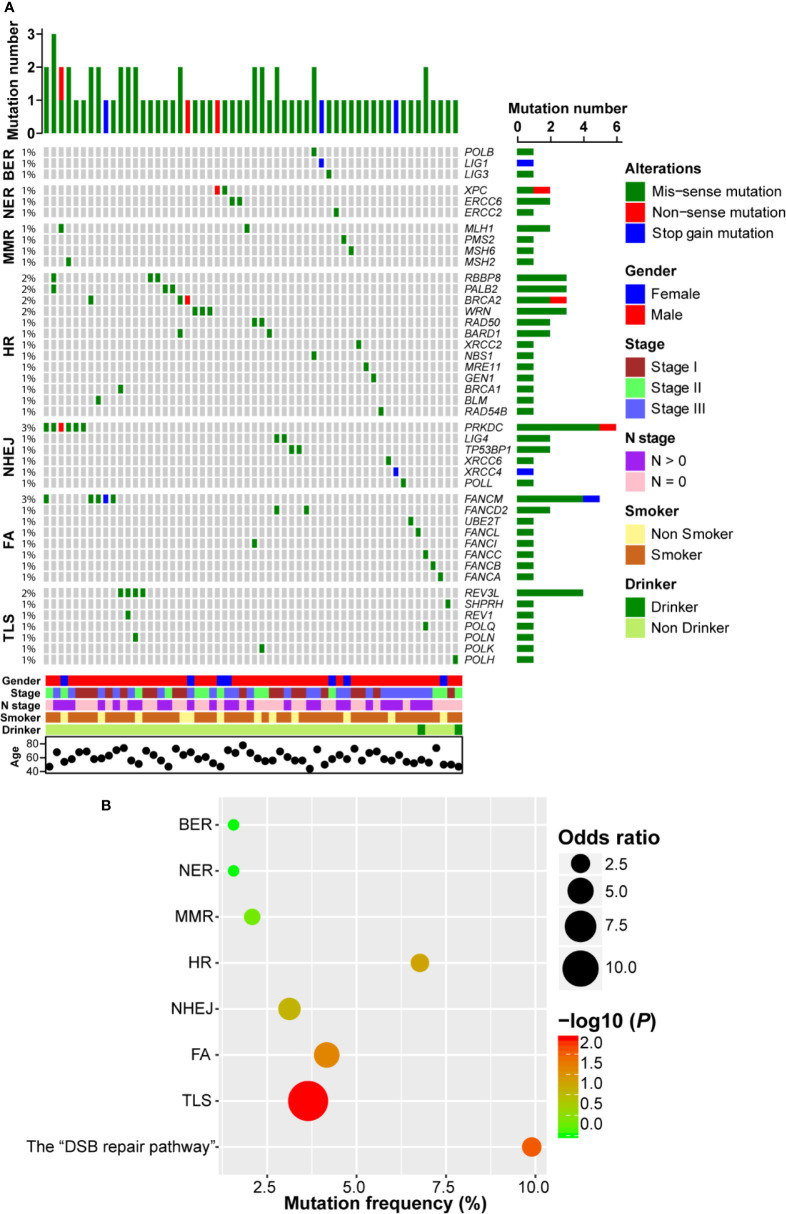
DNA damage repair (DDR) pathway genes were mutated in esophageal squamous cell cancer (ESCC). (A) A complex heatmap that shows the non-silent gene mutation profile in DDR pathways (genes and samples with no gene mutations are removed). The top panel presents the number of gene mutations in each of ESCC samples, and the right panel shows the number of gene mutations in each gene. (B) A bubble plot that depicts the gene mutation enrichment analysis result of DDR pathways.